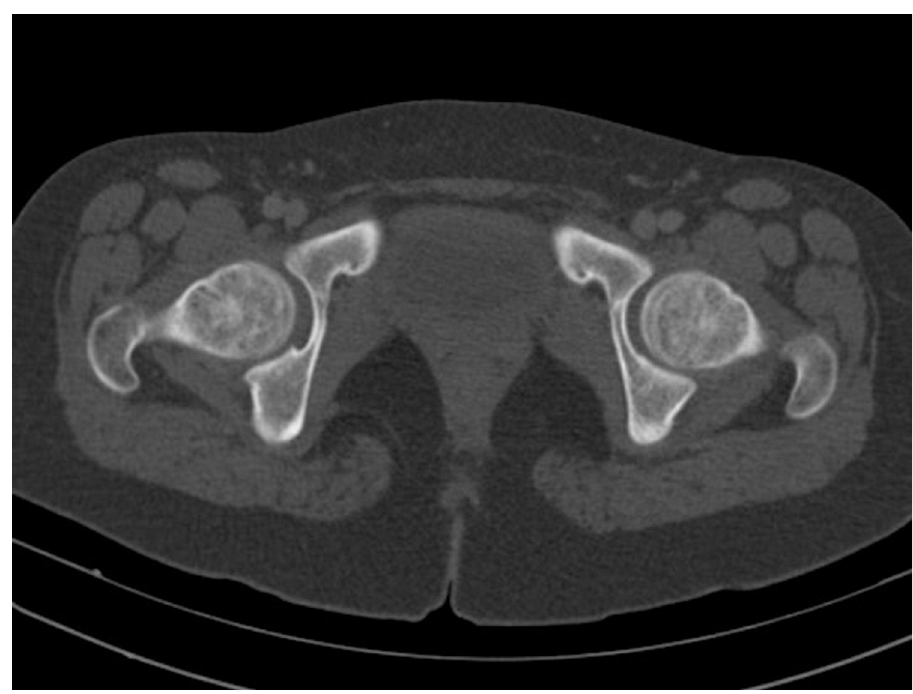
Fig 3. For a patient who is a 16-year-old boy, the axial plane reformatted computed tomography image shows that all three synchondrosis regions are closed.